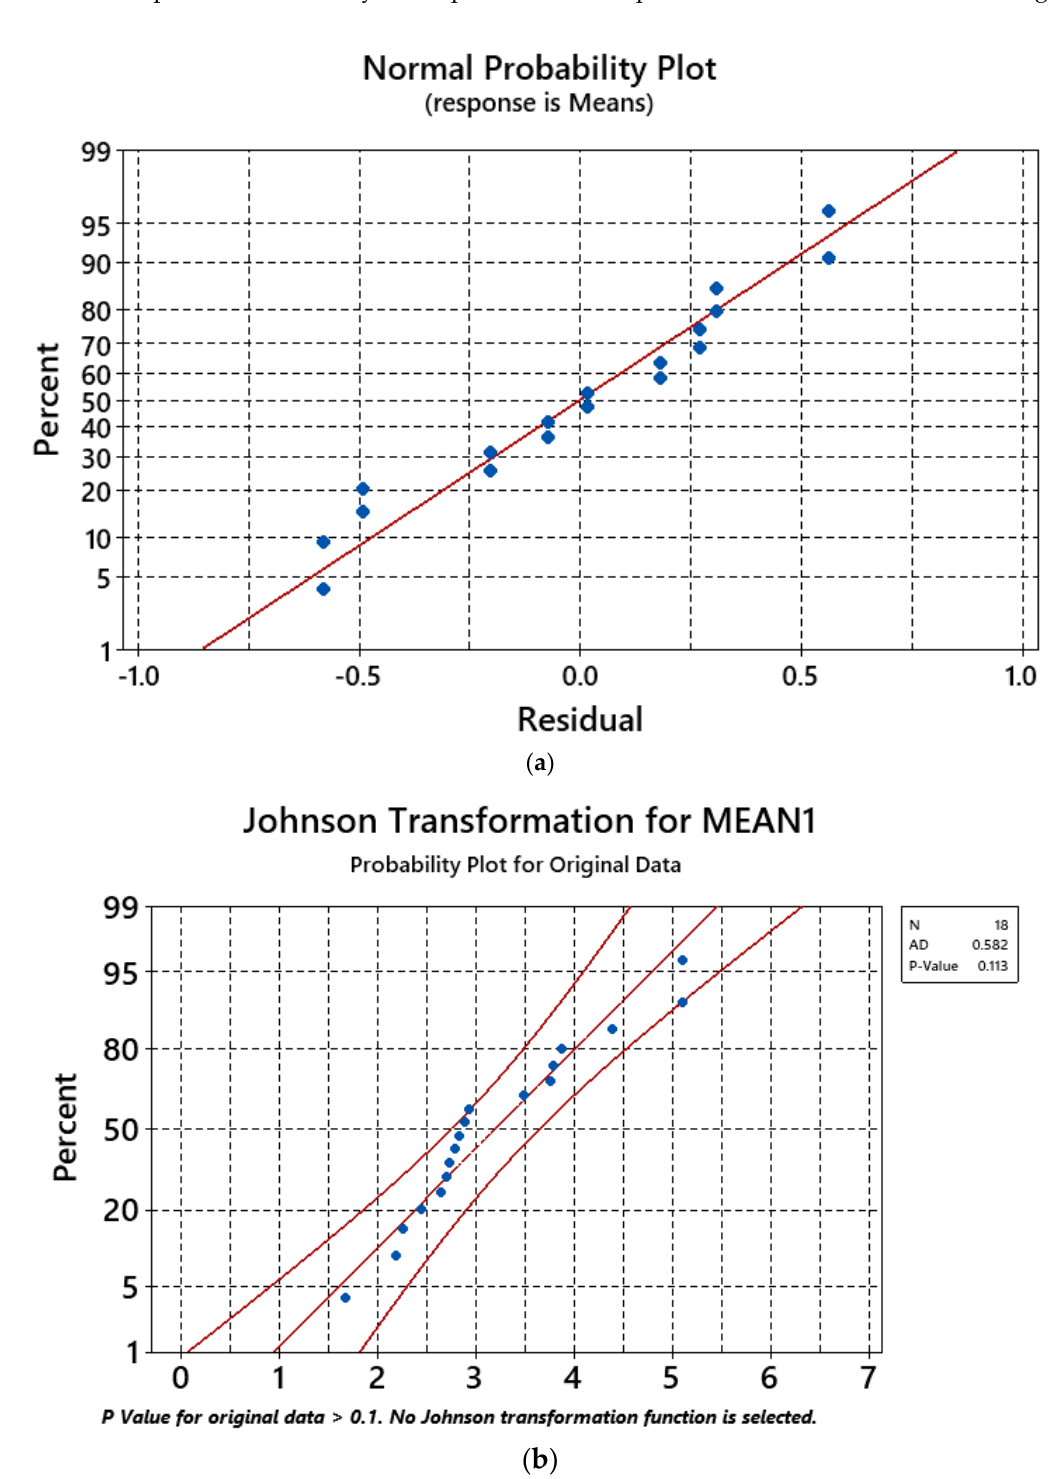
Figure 9. Normal probability and probability plot of surface roughness. ( a ) Normal probability plot